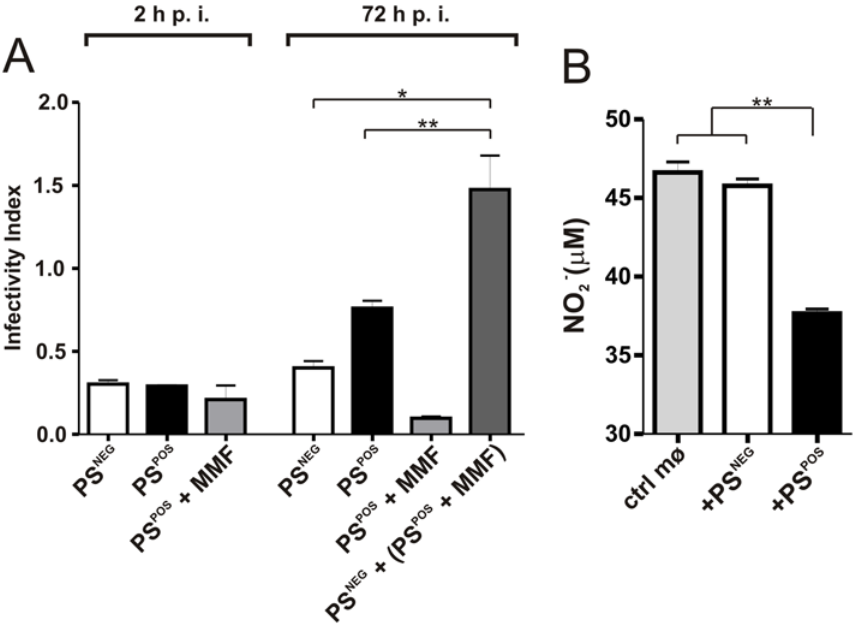
Figure 2. Purified PS POS promastigotes are required for the invitro infectivity of PS NEG forms. ( A ) Rates of internalization (2 h p. i.) and of intracellular proliferation (72 h p. i.) of magnetic purified PS NEG and PS POS metacyclic promastigotes measured by their infectivity index in macrophage cultures. ( B ) Inhibition of NO synthesis by PS POS and PS NEG populations. Macrophages activated with IFN c and LPS were infected with magnetic purified PS NEG or PS POS metacyclic promastigotes. After 48 h of infection, NO production by cultured macrophages were quantified by Griess reaction in the supernatants. Figure displays one experiment out of three with similar results. *p , 0.001, **p , 0.05.